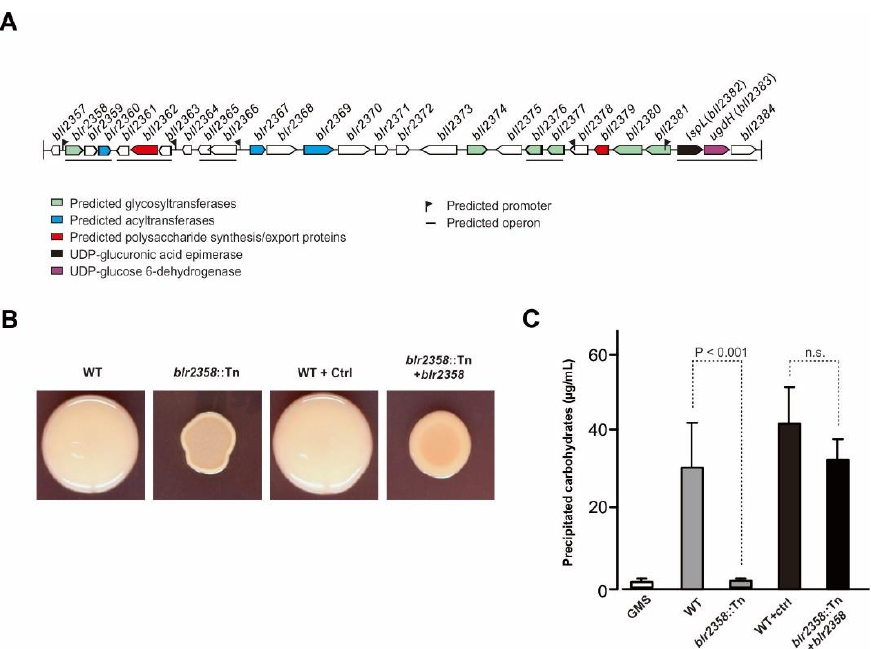
Figure 1. The blr2358 gene of B. diazoefficiens USDA110 is related to polysaccharide biosynthesis. ( A ) Gene cluster of B. diazoefficiens USDA110 containing the blr2358 gene. ( B ) Morphology of Tn5-in- serted blr2358 mutant colonies ( blr2358 ::Tn) as compared to the wild-type strain USDA110 (WT). USDA110 carrying the empty pBBR1-MCS5 plasmid (WT + Ctrl) and the mutant carrying pBBR1- MCS5- blr2358 ( blr2358 ::Tn + blr2358 ) are also shown. Equal amounts of bacteria were spotted on an AG plate containing Congo red and colonies were photographed after incubation at 30 °C for 5 days.